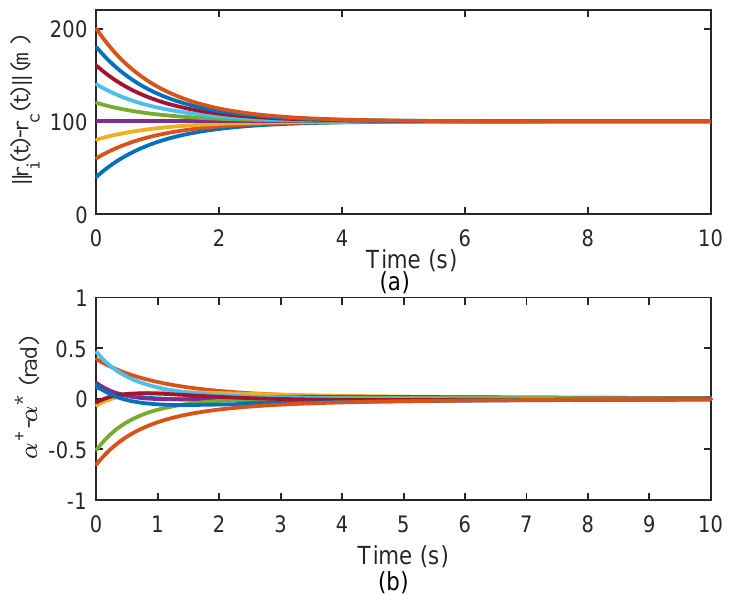
Figure 4. Simulation results of the uniform circle formation when k r = 1 and k θ = 1: ( a ) Evolution of (cid:107) r ( t ) − r c (cid:107) for i = 1,2,..., N on the plane at t ∈ ( 0,10 ] . ( b ) Evolution of (cid:107) α + − α ∗ (cid:107) for i = 1,2,..., N i